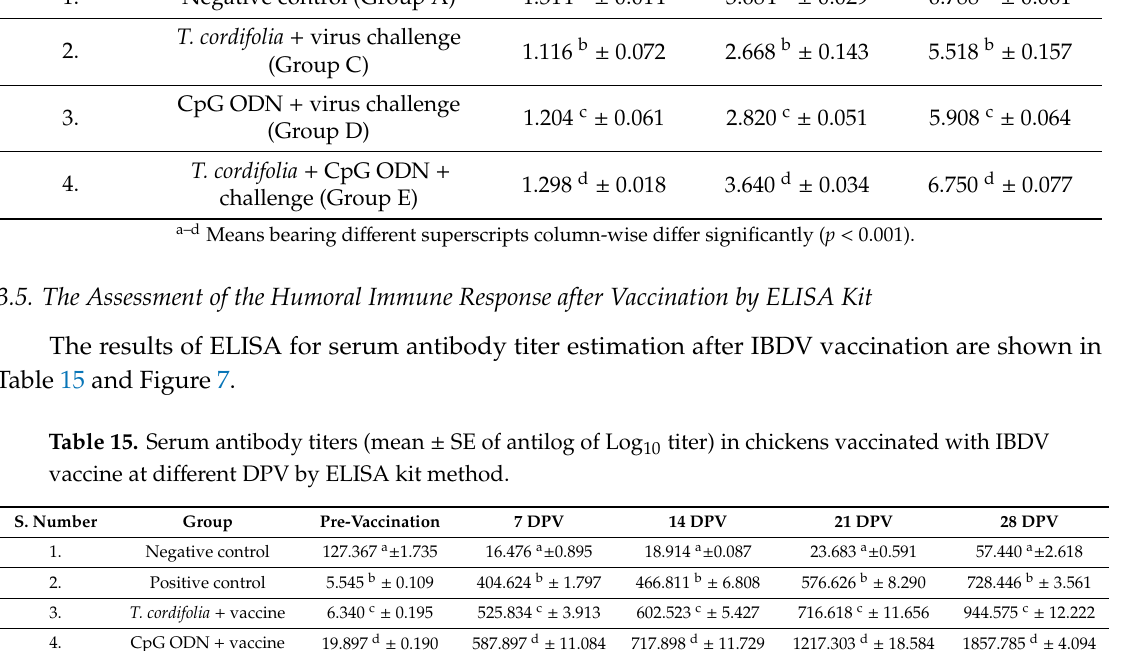
Table 14. Hemagglutination inhibition (HI) antibody titer (mean log 2 HI titer ± SE) against the New Castle disease vaccine in T. cordifolia and / or CpG treated and vvIBDV challenged WL chicken. S. Number